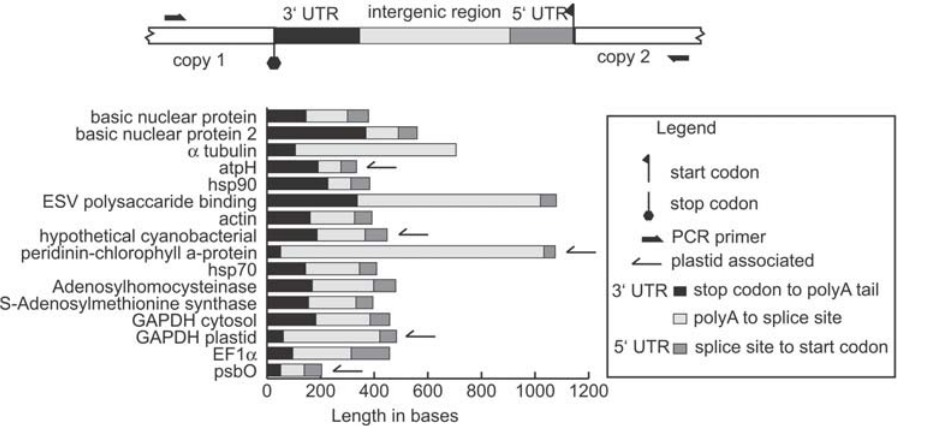
Figure 1. Tandem array intergenic regions from Amphidiniumcarterae . At the top of the figure is a schematic proposed arrangement, applying to all the genes in the survey. The outward primer orientation is designed to amplify between two tandemly arranged copies of the same gene. At the bottom the lengths of the different regions, corresponding to the 3 9 UTR, an intergenic region, and the 5 9 UTR are plotted for each of the different genes. The trans -splicing sites were inferred by comparing cDNA and genomic amplicons. The 3 9 UTR was measured by comparing ESTs and genomic sequences. In the case of a tubulin the splice acceptor site is unknown. Although elongation factor 2 was shown to be in a tandem array arrangement, the end of the coding region is ambiguous, and so this gene is not included.